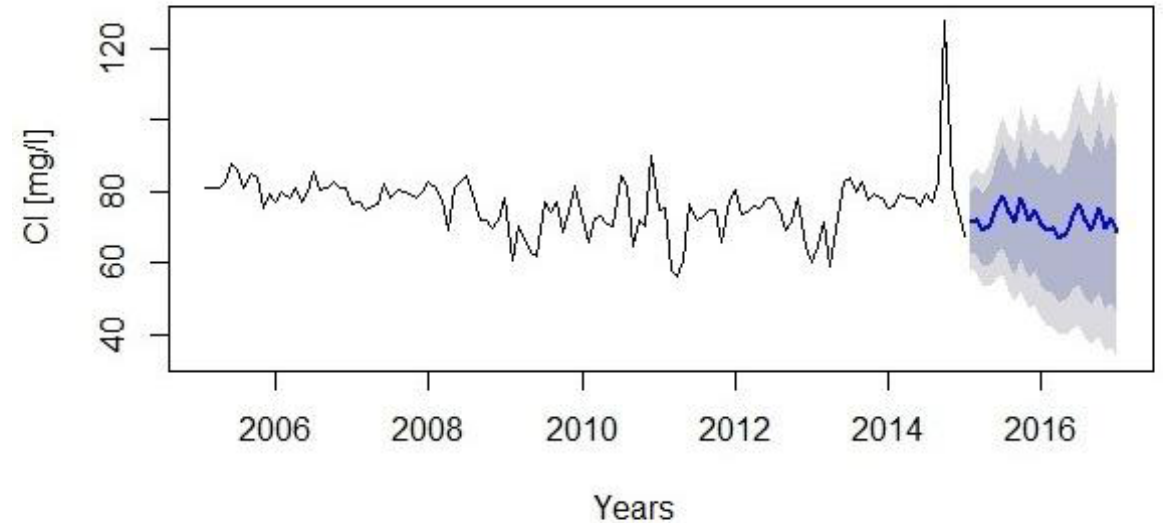
Fig. 4. Forecast of changes in chloride content in the period between February 2015 and February 2017 using the ETS function